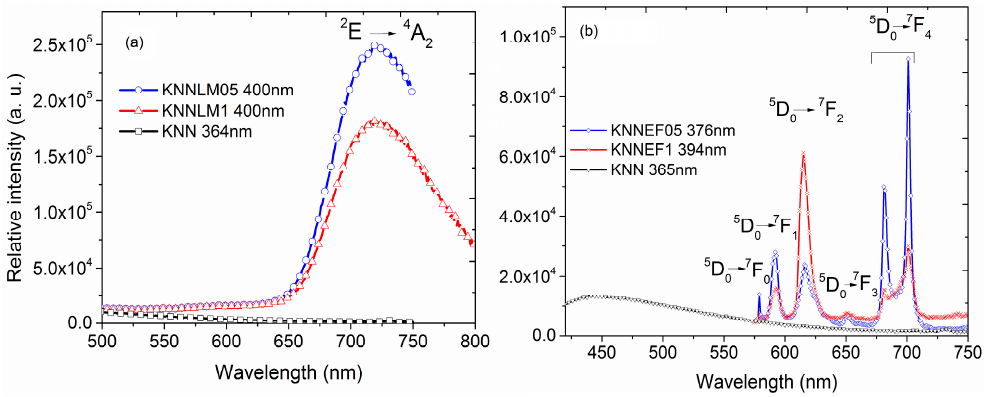
Figure 5. Emission spectra of ( a ) La–Mn co-doped KNN and ( b ) Eu–Fe solid solutions.